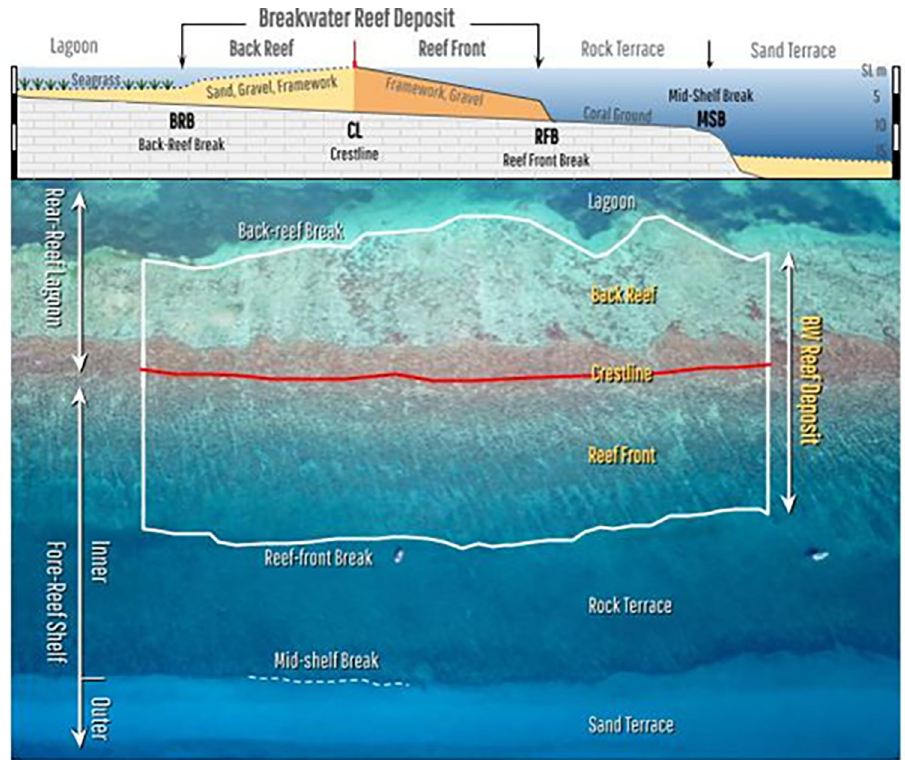
Fig 2. Breakwater reef terminology and geomorphic zonation of shallow benthic seascapes in the Greater Caribbean. The upper profile shows that BW reefs are three-dimensional bio-accretionary benthic structures (geoforms) composed of two geomorphic units—the back-reef and the reef-front—either side of the crestline, where fair-weather waves break. These two units constitute the BW reef deposit. As well as covering the reef deposit, corals are also found veneering non-reefal benthic zones in the wider ecological seascape, such as in the adjacent lagoon and inner fore-reef shelf. The outer fore-reef shelf can also be a depocentre for sand and submerged reef development. The lower image illustrates how a 1-km long section of each reef is sampled to determine 10 morphometric parameters: polygons delineate back-reef and reef front areas, which combine to give total deposit area and size ratio; actual total crestline length is compared to end-to-end length to derive sinuosity, and its persistence is derived from summing the gaps as a percentage of the total length; the reef-front slope is derived from the average distance from the crestline to the mid-shelf break (or 15 m isobath); These 10 morphometric parameters are used to statistically analyse the geomorphology of reef types. Drone image courtesy of Dr. L.